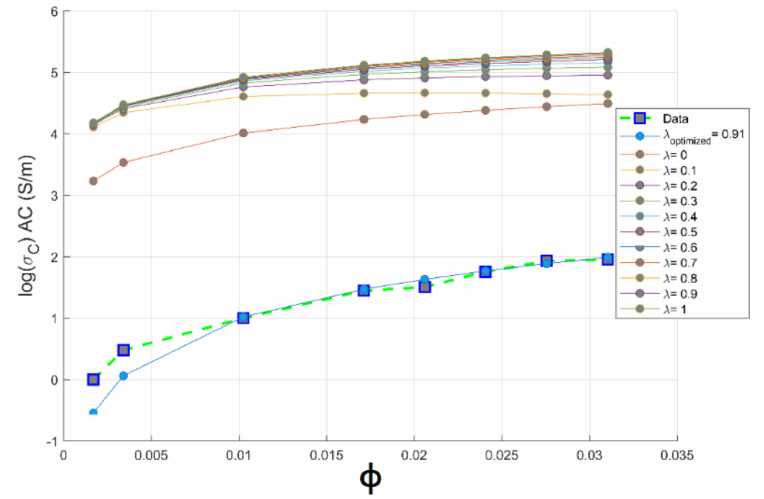
Figure 6. Theoretical and experimental plots of conductivity against volume fraction of CNTs based on McCullough model for PC-CNT conductive composite